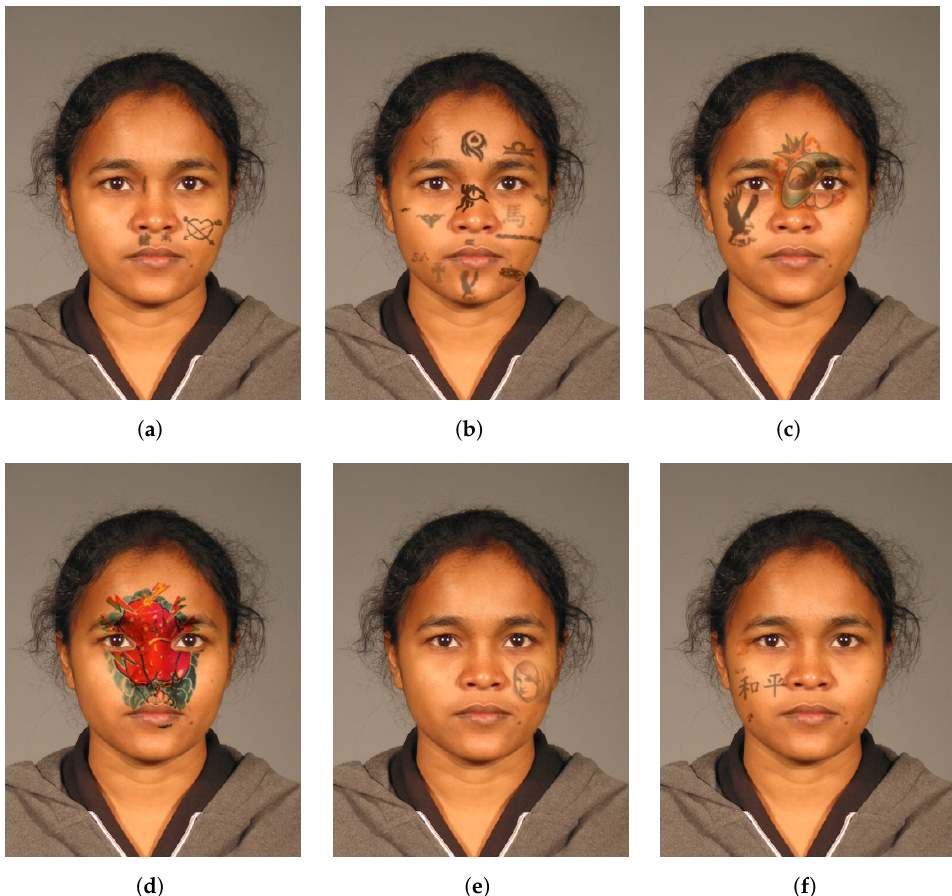
Figure 10. Examples for different types of tattooed faces that can be generated: ( a ) 5%, ( b ) 15%, ( c ) 25% coverage, ( d ) entire face, ( e ) single tattoo, and ( f ) specific region.